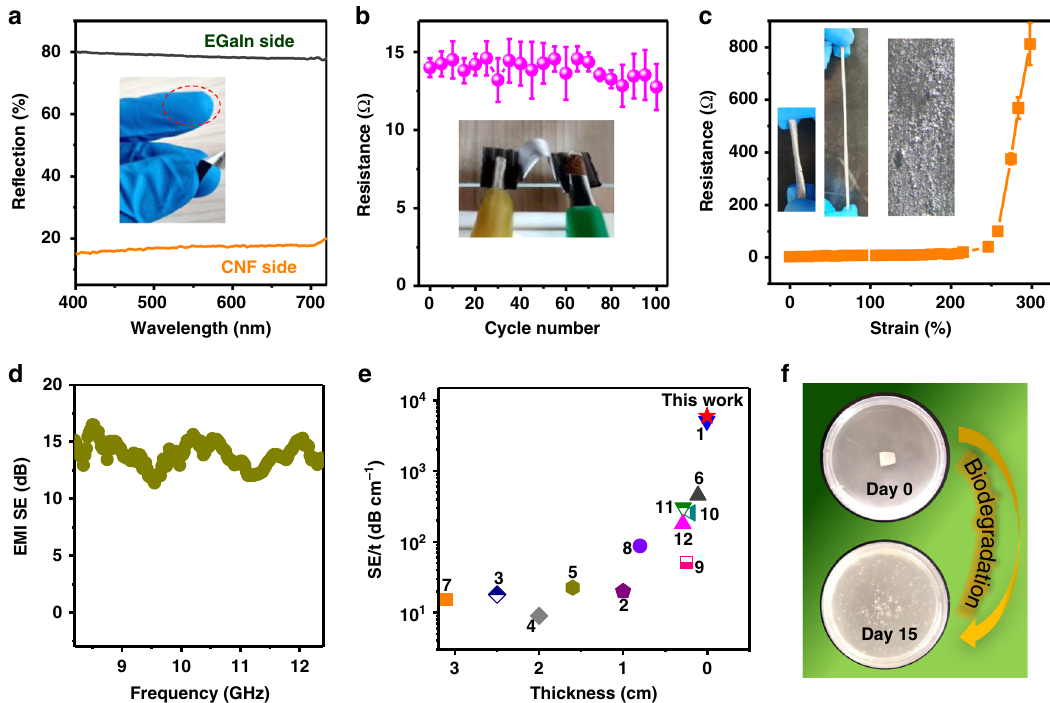
Fig. 2 Physical characterisation of Janus EGaIn fi lm and coating. a Optical re fl ection of CNFs-rich and EGaIn-rich sides. The inset gives endurance of EGaIn side to mild rub. b Cyclic bending endurance evaluated by electric resistance. EGaIn/CNFs layer thickness: 9/10 μ m/ μ m. Bending angle 180°. c Stretching conductivity of EGaIn-rich layer on SEBS. EGaIn layer: 10 μ m. The inset gives optical observation before (Left) and after (Middle & Right) stretching. d Electromagnetic shielding ef fi ciency (EM SE) of EGaIn-rich layer after sintering. EGaIn/CNFs layer thickness: 10/10 μ m/ μ m. e Comparison of SE/t as function of thickness t . 1: Ti 3 C 2 T x /cellulose 26 ; 2: Graphene/PDMS 32 ; 3: Reduced graphene oxide (rGO) 37 ; 4: Carbon black/rubber 28 ; 5: Carbon nanowires/ graphene/PDMS 34 ; 6: Carbon nanotube (CNT)/acrylonitrile-butadiene-styrene 29 ; 7: Steel/PP 33 ; 8: rGO/poly(3,4-ethylenedioxythiophene) 31 ; 9: rGO/ polyetherimide 30 ; 10: Carbon/phthalonitrile 36 ; 11: Ni/polyethersulfone 35 ; 12: Carbon nano fi bers 27 . f Biological degradation of free-standing fi lm in